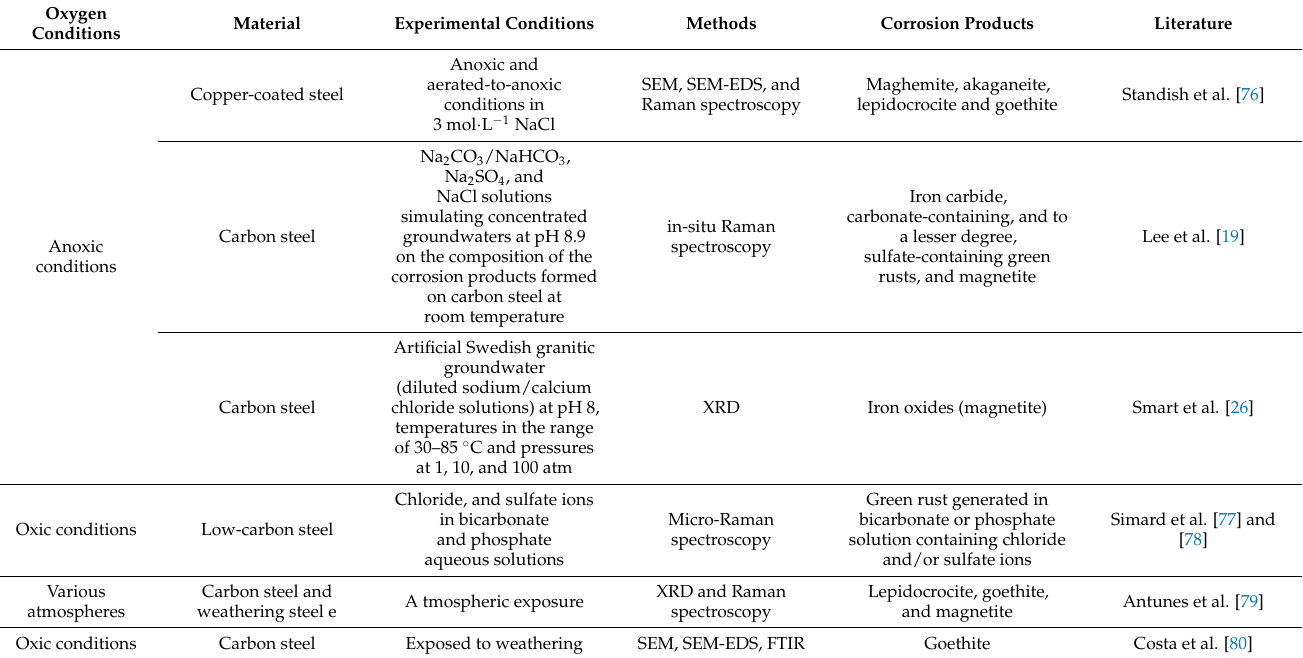
Table 3. Corrosion experiments under oxic and anoxic conditions on various steels with identified corrosion products using spectroscopic